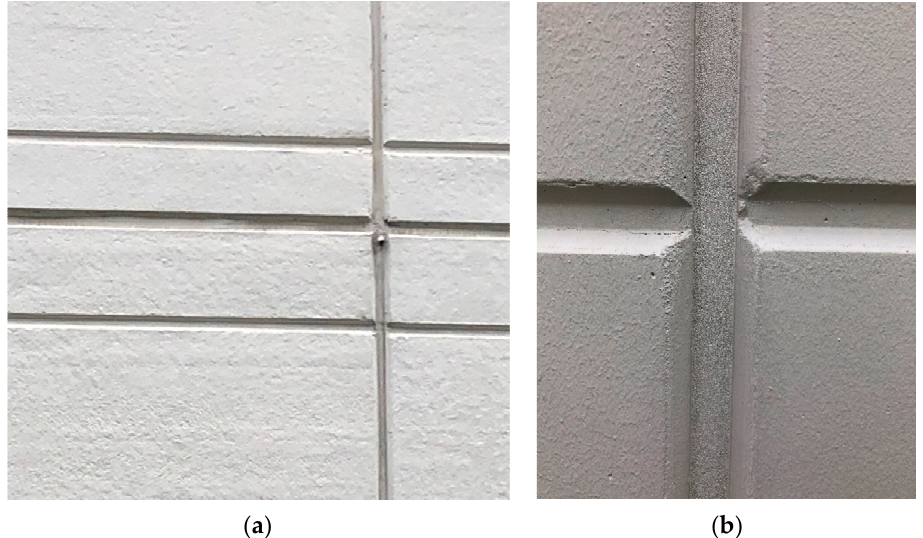
Figure 3. Example of two precast concrete panel facades: ( a ) horizontal and vertical joints using sealant/backing rod and a TDV tube where horizontal and vertical joints meet; ( b ) vertical joint using pre-compressed joint sealing tape.